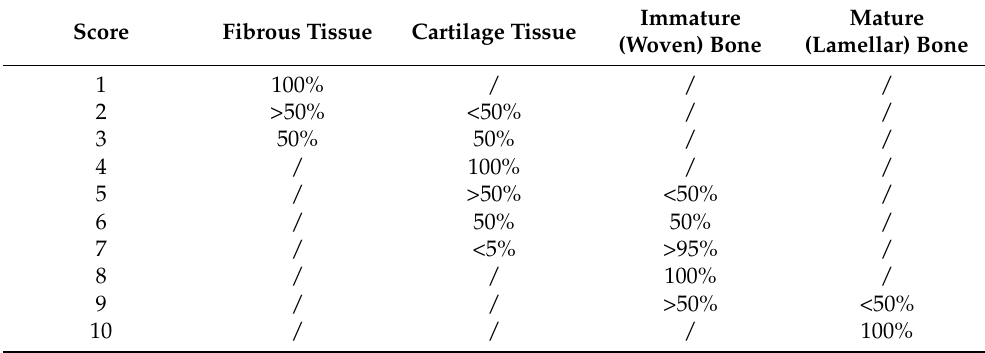
Figure 3. Assessment of bone ingrowth/ongrowth of porous cages on the histologic section. Zone A, bone inside cage between two endplates (Bone graft); Zone B, bone inside cage (bone ingrowth); Zone C, bone surrounding the implant (Bone ongrowth). Table 1. Modified bone healing score for the healing of autogenous bone graft between two vertebral endplates derived from Perry et al.